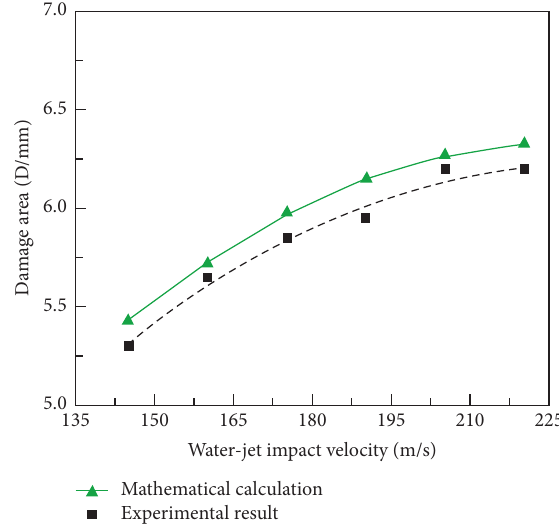
Figure 8: Effect of water-jet impact velocity on damage area (test time with 10s; particle diameter with1.0 mm; impact angle with 0 ° ).